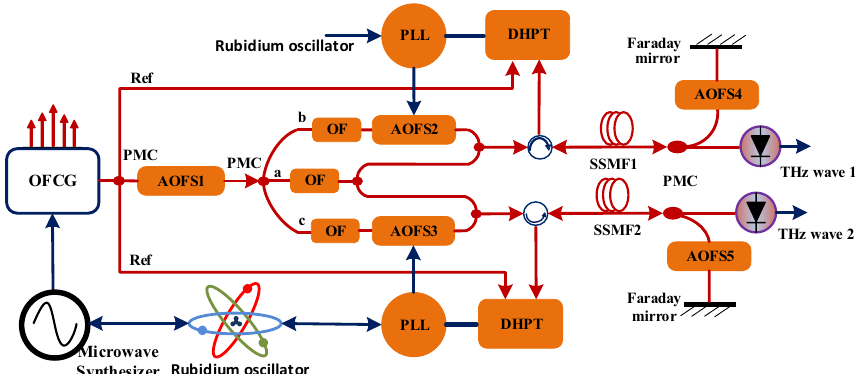
Fig. 2 The schematic diagram of the terahertz wave distribution on branching optical-fiber networks. OFCG, optical frequency comb generator; PMC, polarization maintained coupler; OF, optical filter; AOFS, acousto-optic frequency shifter; PLL, phase-locked loop; DHPT, dual-heterodyne phase error transfer; SSMF, standard single-mode